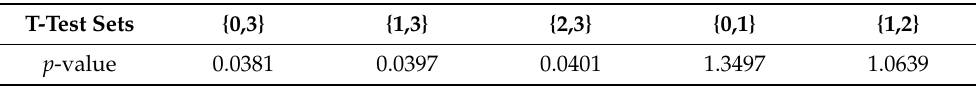
Table 4. Risk level analysis. i , j denotes calculating the p -value between risk level i and level j , i , j ∈ { 0,1,2,3 }